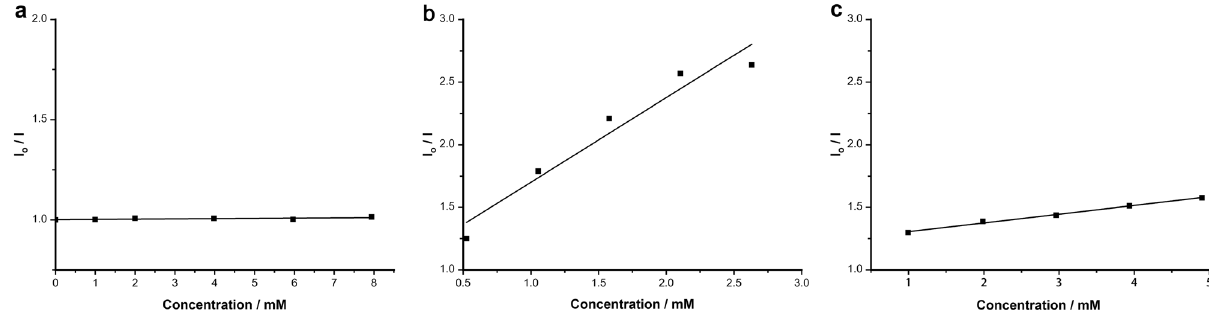
Fig. 6 Stern – Volmer quenching experiments. a With substrate 2a . b With HEH. c With Et